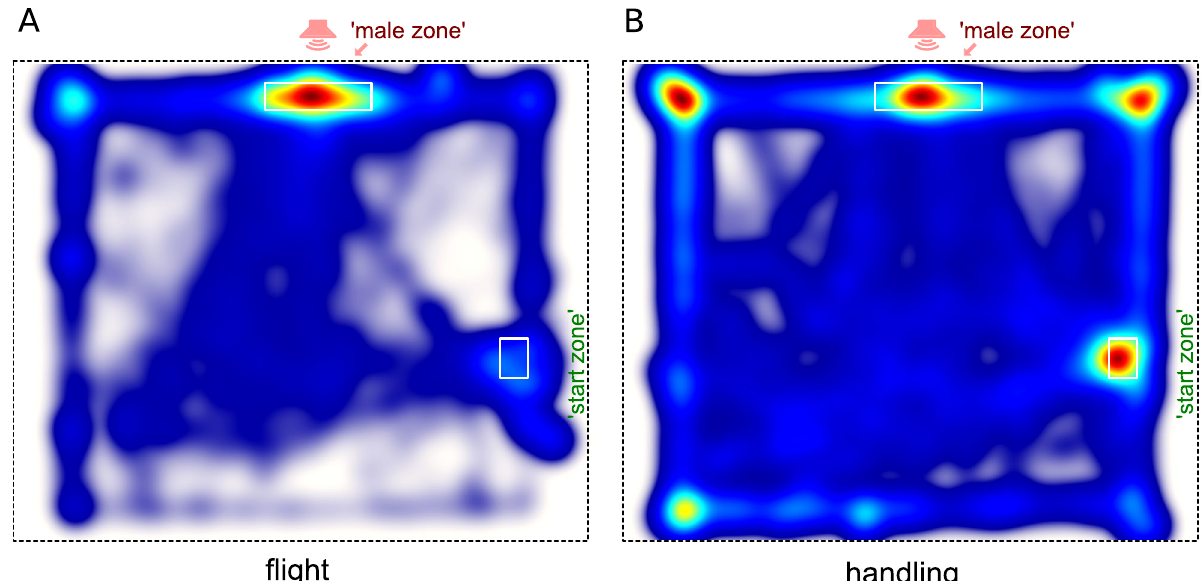
Figure 3. Heatmaps show the data from all crickets in the ’flight’ group (A) and the handled group (B) normalized proportionally to the time spent by crickets in each site of the arena, from blue to red. ’Flight’ crickets demonstrate clear preference for the ‘Male zone’ in contrast to the control group, showing preferences for the home container area and the corners of the arena as well. White boxes indicate the ’Male zone’ close to the loudspeaker (that was situated outside the arena and hidden behind the fabric wall) and the position of the home container, in which a cricket was put into the arena and which it was allowed to leave